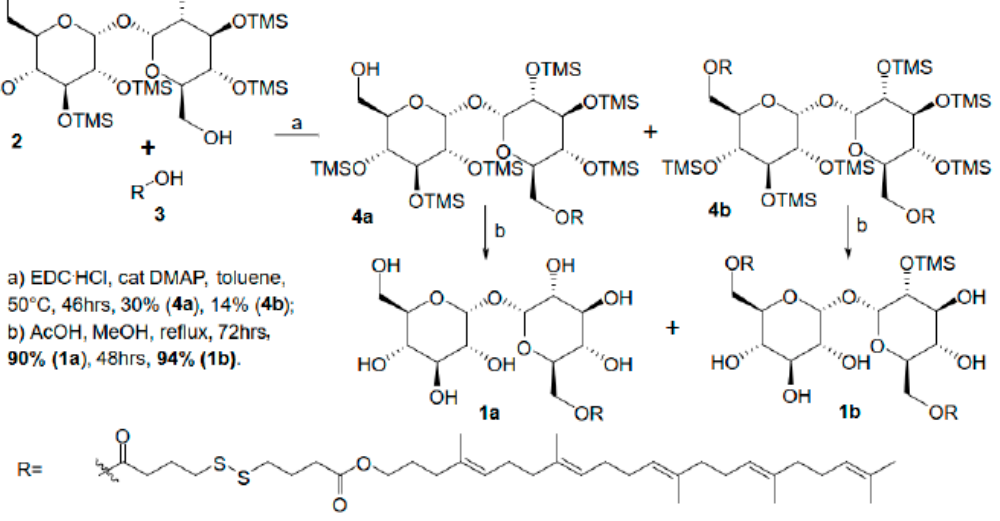
Scheme 1. Synthesis of mono- ( 1a ) and bis- ( 1b ) squalene-trehalose adducts for self-assembling organic